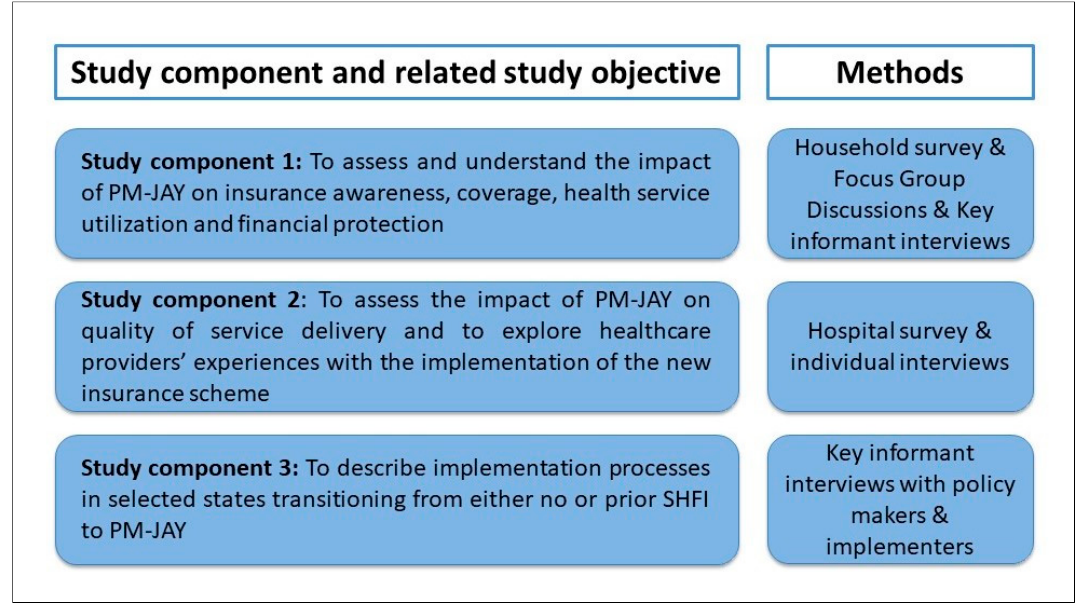
Figure 2. Study components, study objectives, and methods.